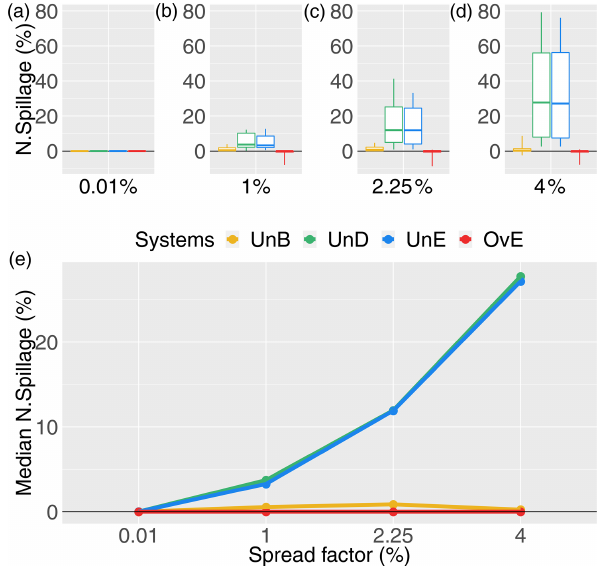
Figure 14. Spilled water from the management based on the syn- thetic ensemble forecasting systems as a percentage of the total spillage of the reference system (i.e., the “perfect system”, where forecasts are equal to observations): unbiased system (UnB, yel- low), underdispersed system (UnD, green), underestimating system (UnE, blue) and overestimating system (OvE, red). Synthetic sys- tems are based on ensembles generated with four different spread factors (0.01%, 1%, 2.25% and 4%). (a–d) Boxplots represent the maximum value, percentiles 75, 50 and 25, and minimum value over the 10 studied catchments. (e) Median